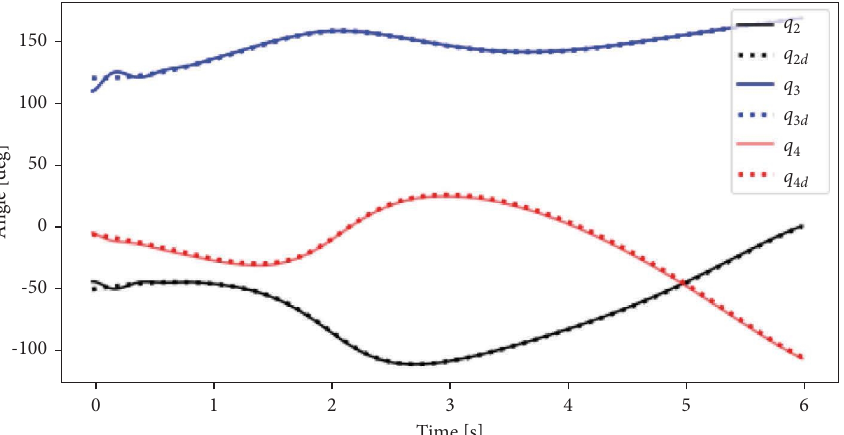
Figure 9: Te desired and actual joint